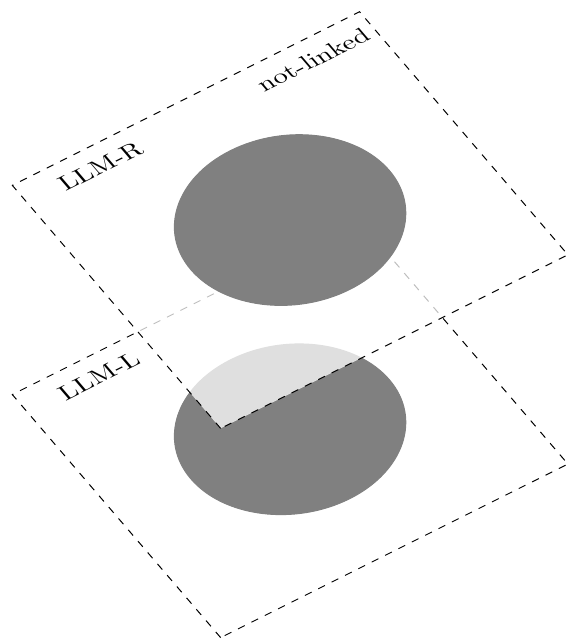
Figure 15 . Two unentangled LLM droplets corresponding to singular one sided